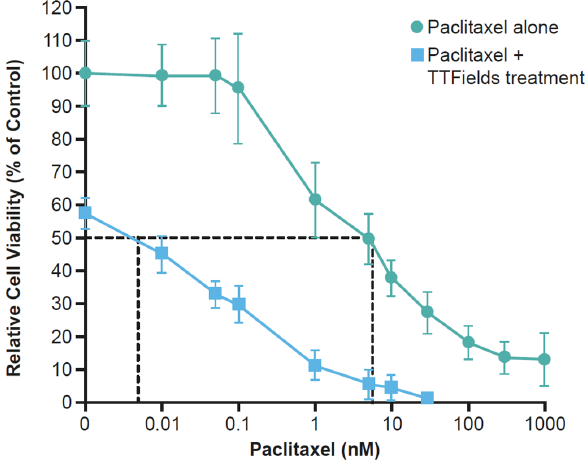
Figure 8. The effects of 72 ‐ h exposure of human breast carcinoma (MDA ‐ MB ‐ 231) cells to paclitaxel alone at different concentrations and concomitant with TTFields treatment [90] . TTFields, Tumor Treating Fields. Reproduced from Kirson ED et al. Chemotherapeutic treatment efficacy and sensitivity are increased by adjuvant alternating electric fields (TTFields). BMC Med Phys. 2009, 9, 1.